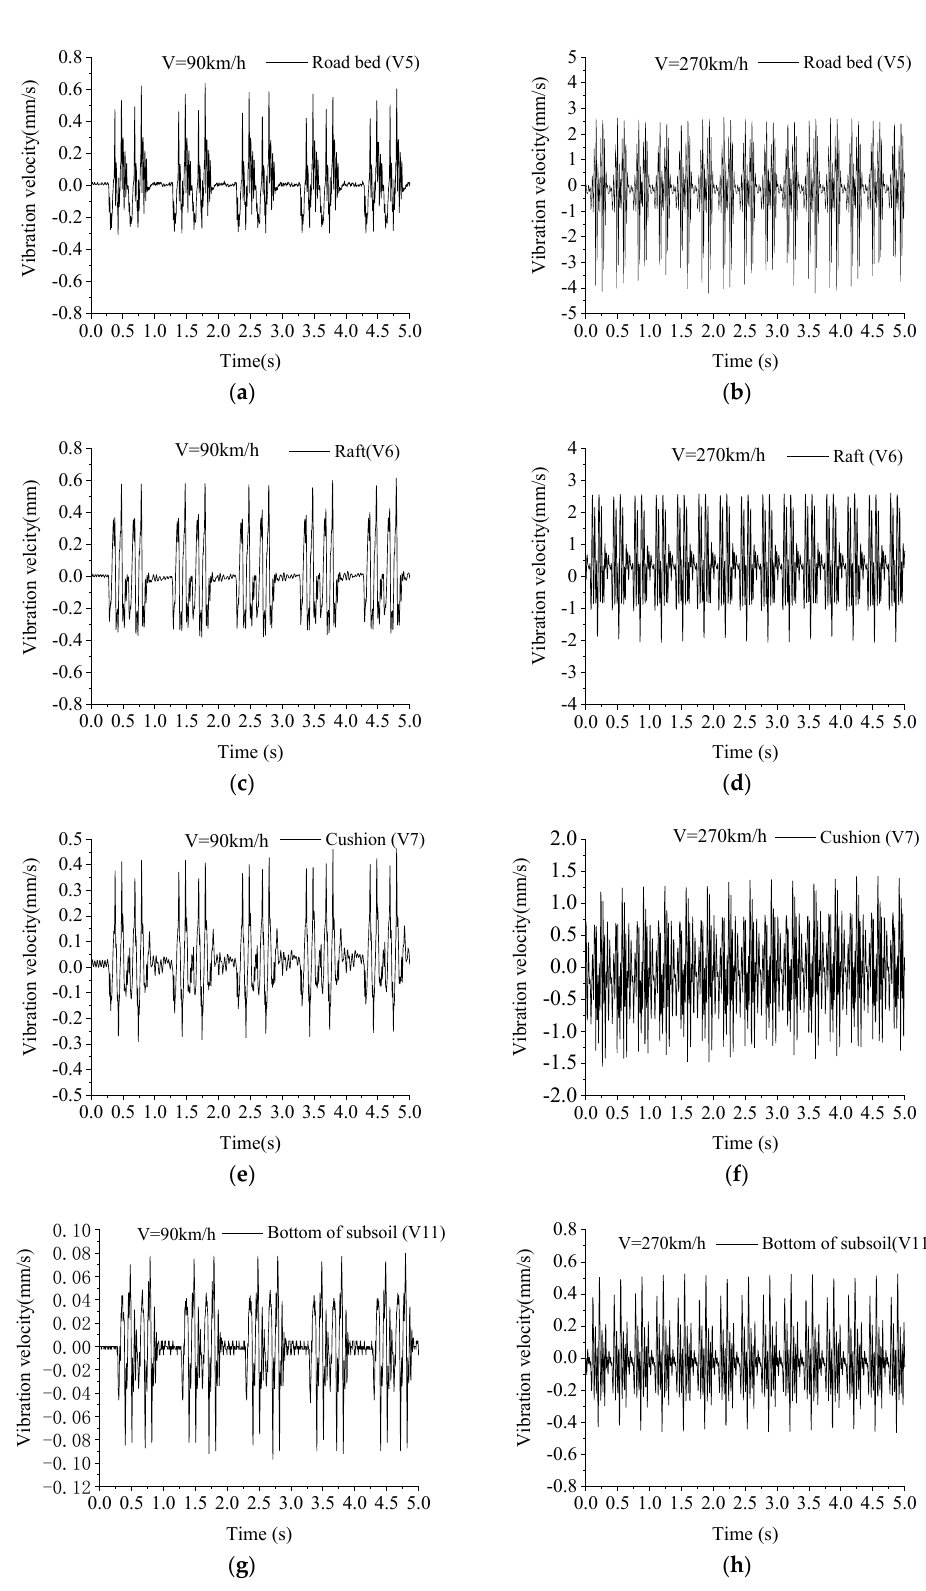
Figure 9. Time history curves of vibration velocities at different locations of the pile–raft foundation. ( a ) Roadbed (V5, v = 90 km/h), ( b ) Roadbed (V5, v = 270 km/h), ( c ) Raft (V6, v = 90 km/h), ( d ) Raft (V6, v = 270 km/h), ( e ) Cushion (V7, v = 90 km/h), ( f ) Cushion (V7, v = 270km/h), ( g ) Bottom of subsoil (V11, v = 90 km/h), ( h ) Bottom of subsoil (V11, v = 270